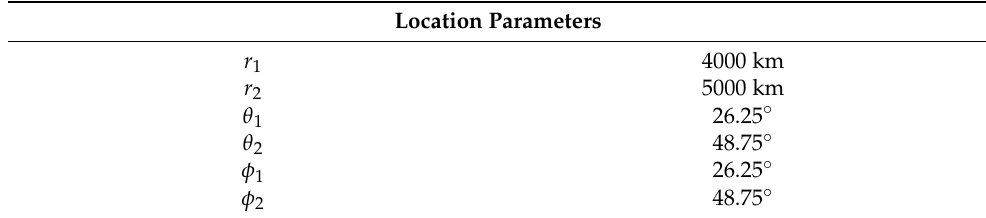
Table A1. Location parameters of the spherical prism